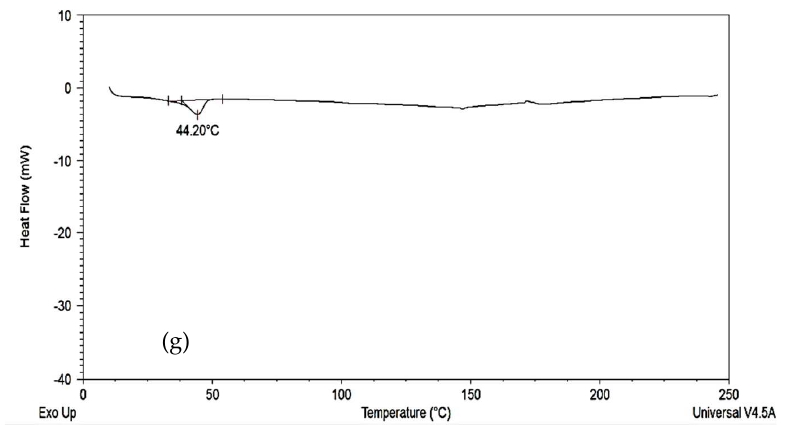
Figure 6. DSC thermograms of ( a ) Poloxamer 407, ( b ) magnesium stearate, ( c ) MCC, ( d ) PEG400, ( e ) Aerosil®, ( f ) Formulation B, ( g ) a physical mixture of Formulation B (commercial curcumin: PEG 400: Poloxamer 407: MCC: Aerosil®: magnesium stearate 1:0.5:0.9:5.6:0.1:0.1), showing the endothermic peaks.